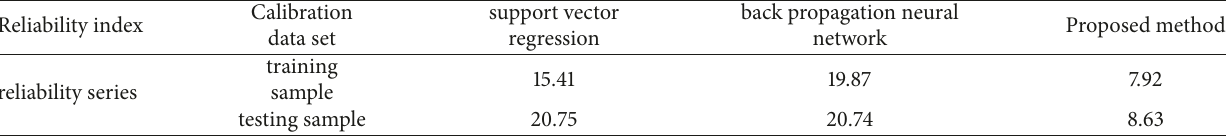
Table 1: SAPE of proposed method and referenced method for upper-phase model based on weekday data (%).